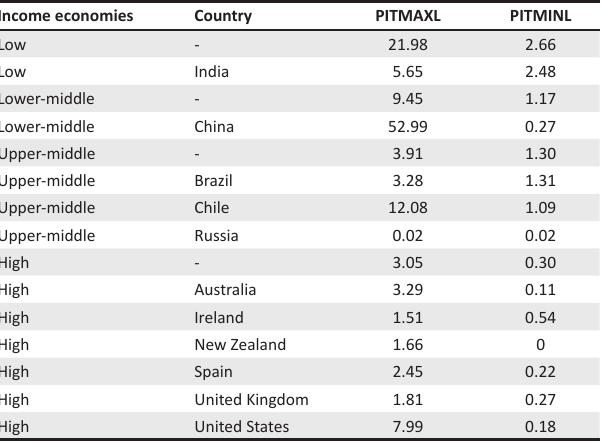
FIGURE 2: GDP/per capita for high income countries, 2009/2010. TABLE 1: Lowest and highest level of income indicators for 2009/ 20